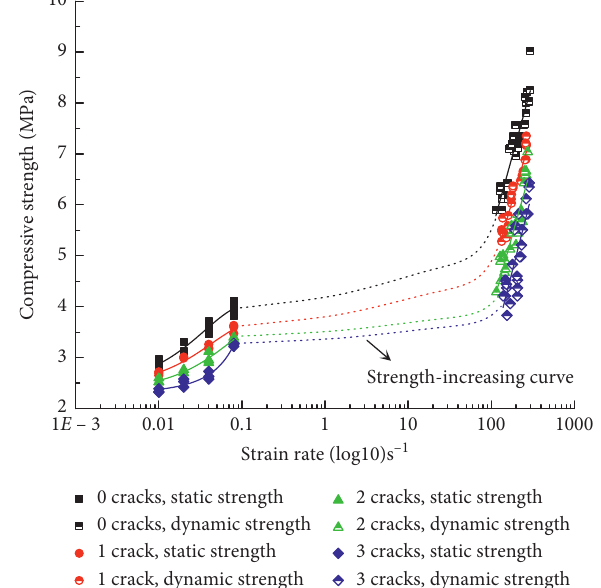
Figure 7: Static and dynamic strengths of frozen silty soil with various prefabricated crack numbers.